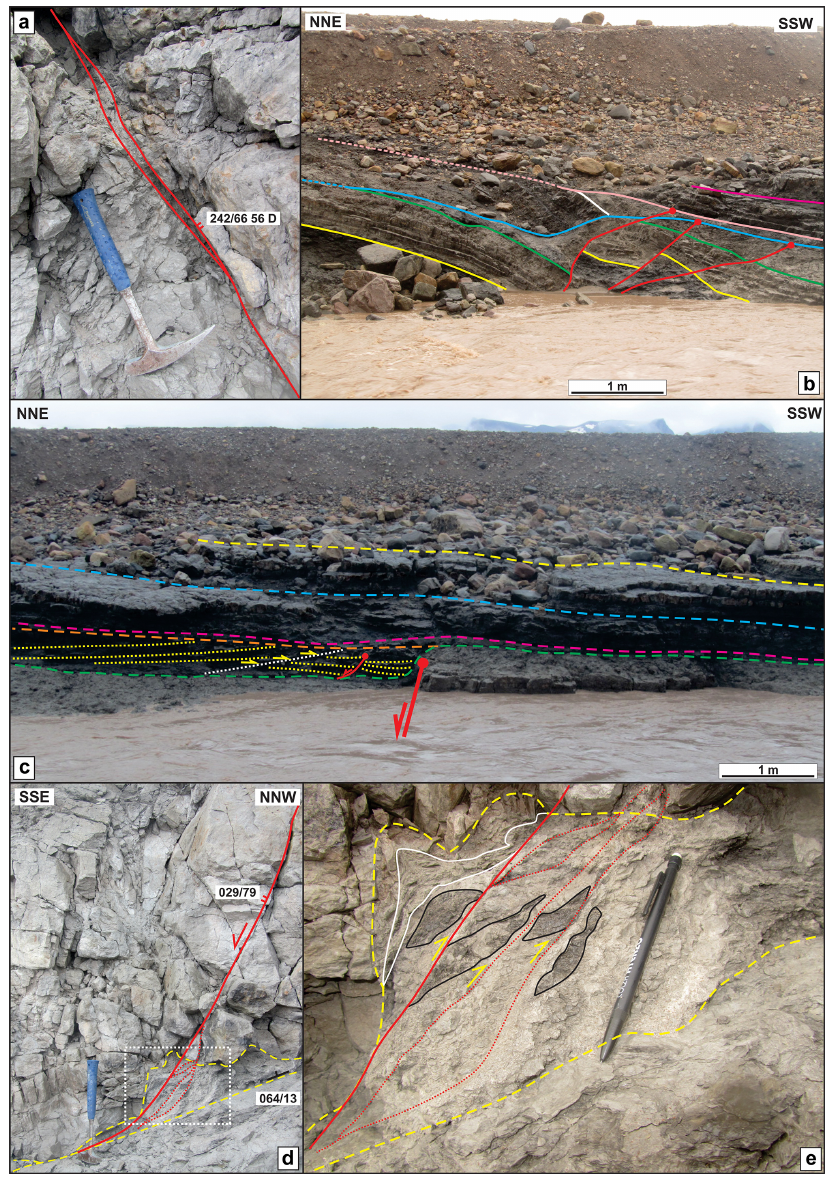
Figure 8. Outcrop photographs showing (a) centimeter–decimeter-thick lenses of light-colored fault gouge along a brittle fault truncating grey sandstones of the Billefjorden Group. Figure location in Fig. 4. (b) NNE-dipping normal faults showing meter-scale down-NNE movement and potential growth strata (between the green and blue markers). The faults crosscut sandstones and shales of the Billefjorden Group in which they die out upwards. See Fig. 4 for location. (c) Potential fault-growth strata made of dark sandstone (between the green and orange markers) in the hanging wall of a NNE-dipping brittle fault with decimeter–meter-scale normal displacement. The fault dies out upwards within sedimentary strata of the Billefjorden Group. The interpreted syn-tectonic growth strata are composed of two sedimentary packages, including a proximal sandy wedge thickening towards the fault and a distal prograding to sheet-like sand-rich body onlapping (divergent onlap; yellow arrows) the proximal wedge. The two packages are separated by an angular unconformity (dotted white line) and are both eroded upwards (orange dashed line). Yellow dotted lines represent intra-bed surfaces. Outcrop location in Fig. 4. (d) Outcrop photograph showing a high-angle brittle normal fault (red line) in grey sandstone of the Billefjorden Group flattening and soling into a gently south- dipping shale-dominated bed (dashed yellow lines) displaying significant thickness variations. The dotted white frame shows the location of (e) , and white boxes show structural measurements (fault surface in red and bedding surface in black). See Fig. 4 for outcrop location. (e) Zoomed-in photograph showing thickening of the shale-dominated bed (dashed yellow lines) in the footwall of the flattening normal fault (red line), including fine-grained (meso- to ultra-) cataclasite and preserved fragments of coaly shale host rock (black lines) seemingly offset in a reverse top-northwest fashion by small-scale faults that form a duplex-shaped structure (dashed red lines). In the hanging wall, the shale-dominated bed significantly thins and is preserved as a lens of partly squeezed shale (white line) and cataclasite. Location shown by a dotted white frame in (d)